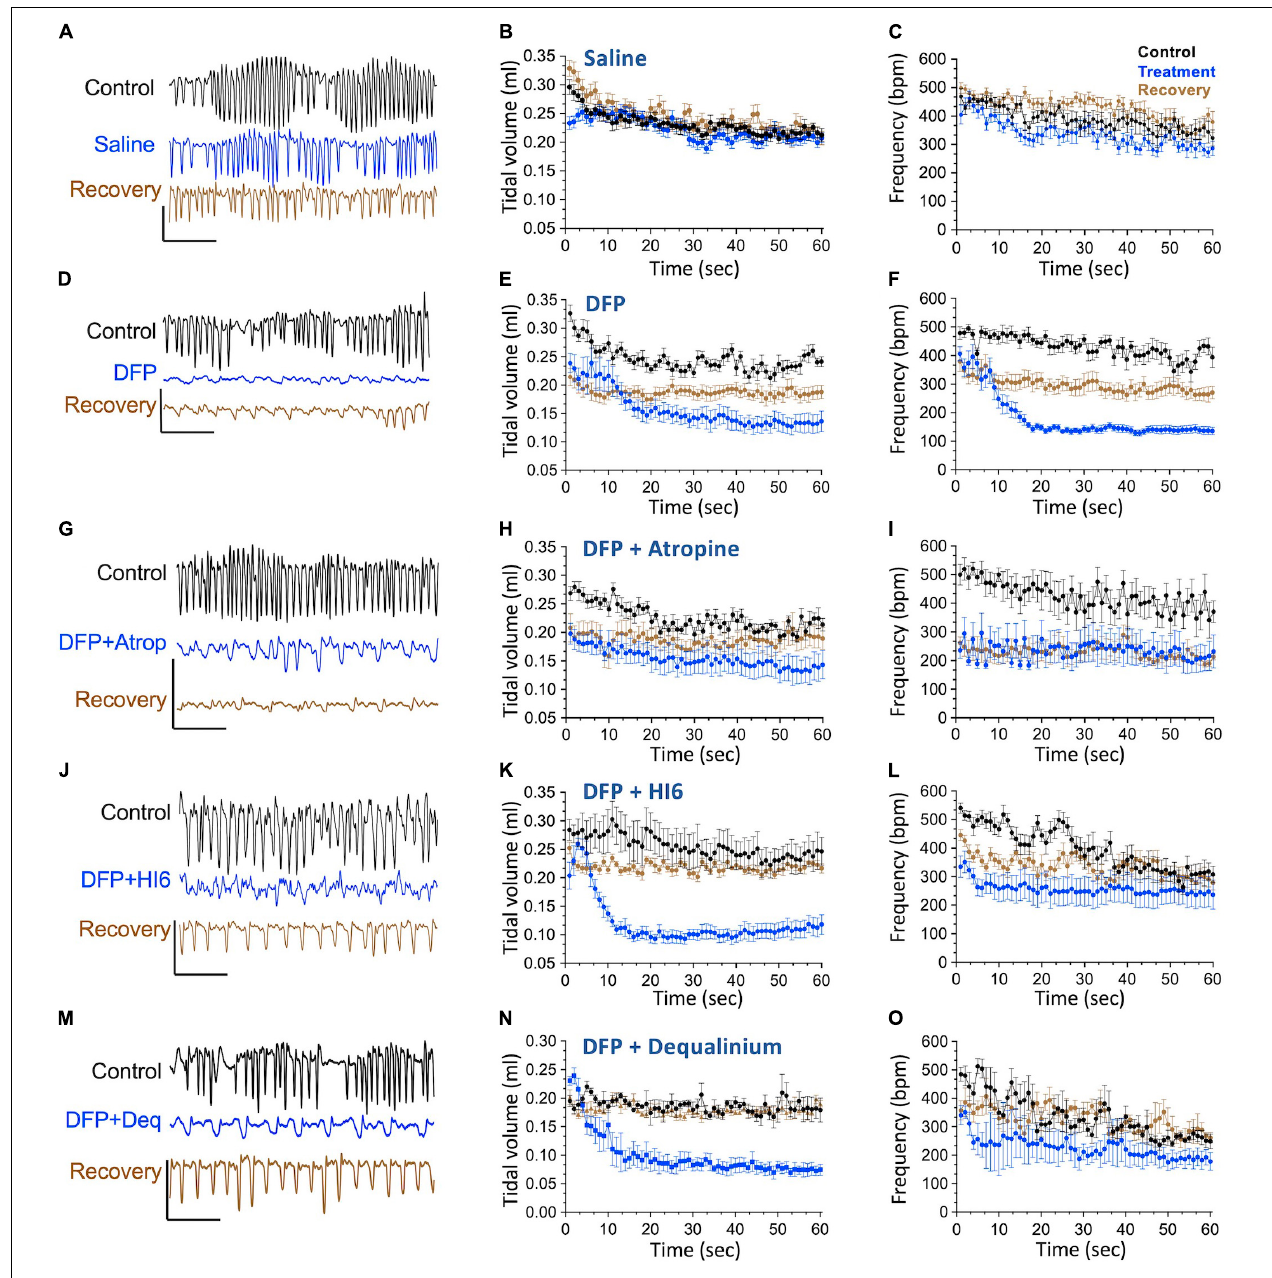
FIGURE 3 | Timeline of breathing frequency (breaths per minute) and tidal volume (ml) in response to diisopropylfluorophosphate (DFP) alone or DFP with treatments. Left panels (A,D,G,J,M) show example flow traces for mice before (black), acutely after treatment (treatment indicated, blue) and 22–24 h after treatment (brown, recovery). Middle and right panels show averages of tidal volumes (ml volumes, middle panels) and breathing frequency (breathes per minute, right panels) before (control, black), acutely after treatment (treatment, blue), and 22–24 h after treatment (brown, recovery) for saline treatment (B,C) , DFP alone (E,F) , DFP with Atropine (H,I) , DFP with HI6 (K,L) , and DFP with dequalinium chloride (N,O) . Data is for analysis of 10 mice for saline alone, 10 mice for DFP alone, seven mice for DFP with atropine, eight mice for DFP with HI6, and four mice for DFP with dequalinium chloride. Scale bars in the left panels indicate 1 ml/s flow (vertical) and 1 s time